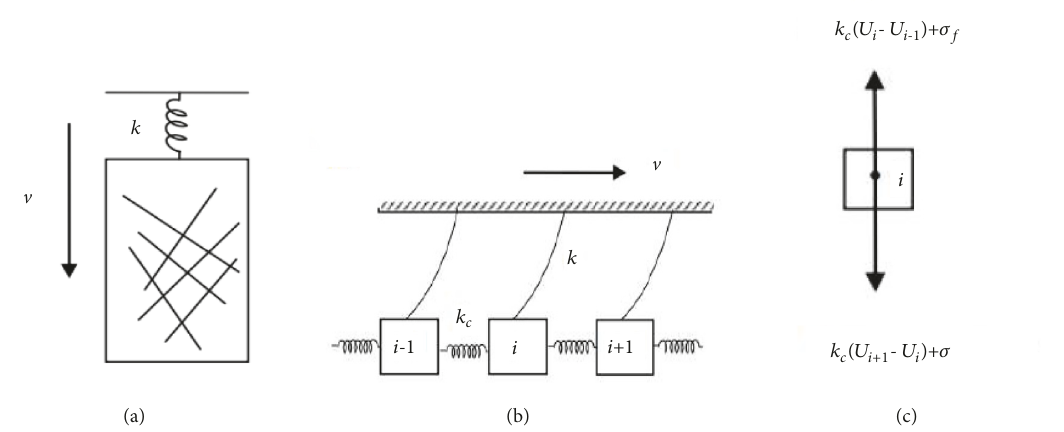
Figure 1: The schematic diagram of the plastic deformation considering the mutual interaction between the shear bands and force analysis for the multiple shear bands. (a) The multiple shear bands during the plastic deformation. (b) Chain of the blocks parallel to the direction of loading speed V . (c) The force diagram for the i-th